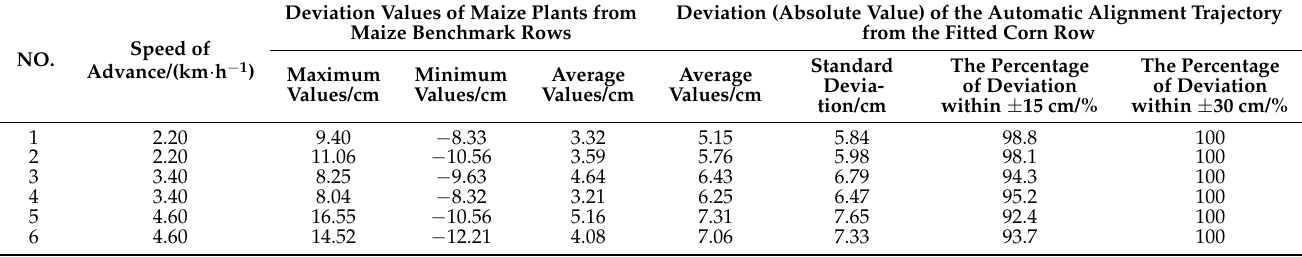
Table 4. Experimental results of automatic row-to-row harvesting control